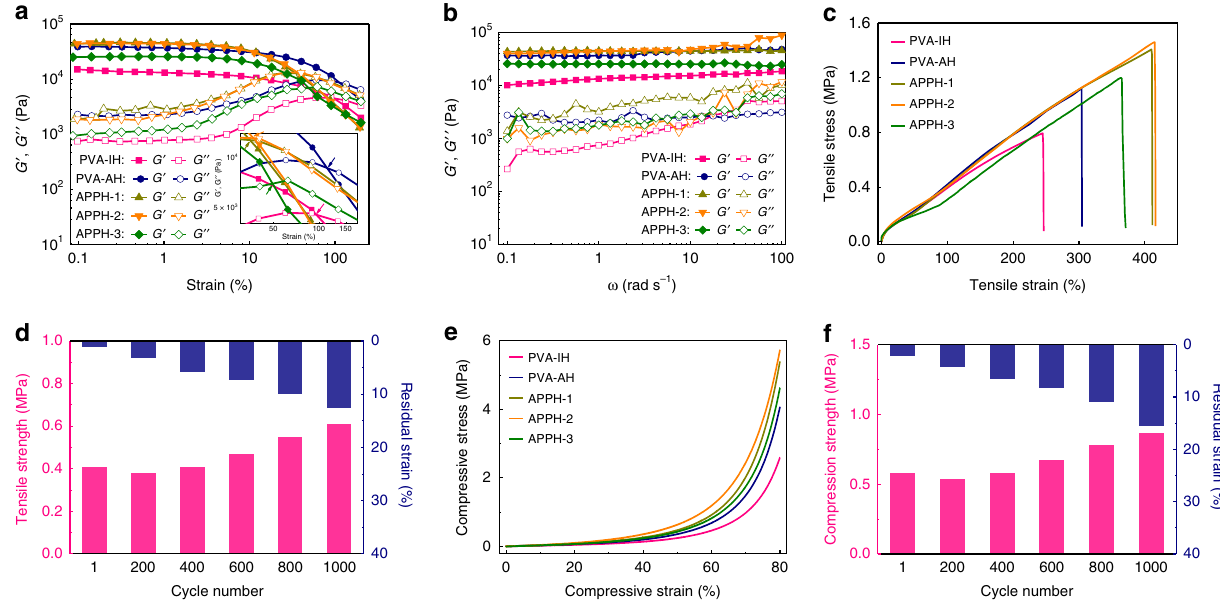
Fig. 3 Mechanical performance of the anisotropic hybrid hydrogels. a Rheological strain sweeping measurements of PVA anisotropic hydrogel (PVA- AH), PVA isotropic hydrogel (PVA-IH) and anisotropic polyvinyl alcohol/polyaniline hydrogel (APPH) at an angular frequency of 1 rad s − 1 . b Angular frequency sweeping measurements of PVA-IH, PVA-AH and APPH at a constant strain of 0.5%. c Tensile stress-strain curves of PVA-AH, PVA-IH and APPH. d Tensile strength and residual strain of APPH-2 after different stretching cycles of successive loading-unloading at a strain of 100%. e Compressive stress-strain curves of PVA-AH, PVA-IH and APPH. f Compression strength and residual strain of APPH-2 after different compression cycles of successive loading-unloading at a strain of